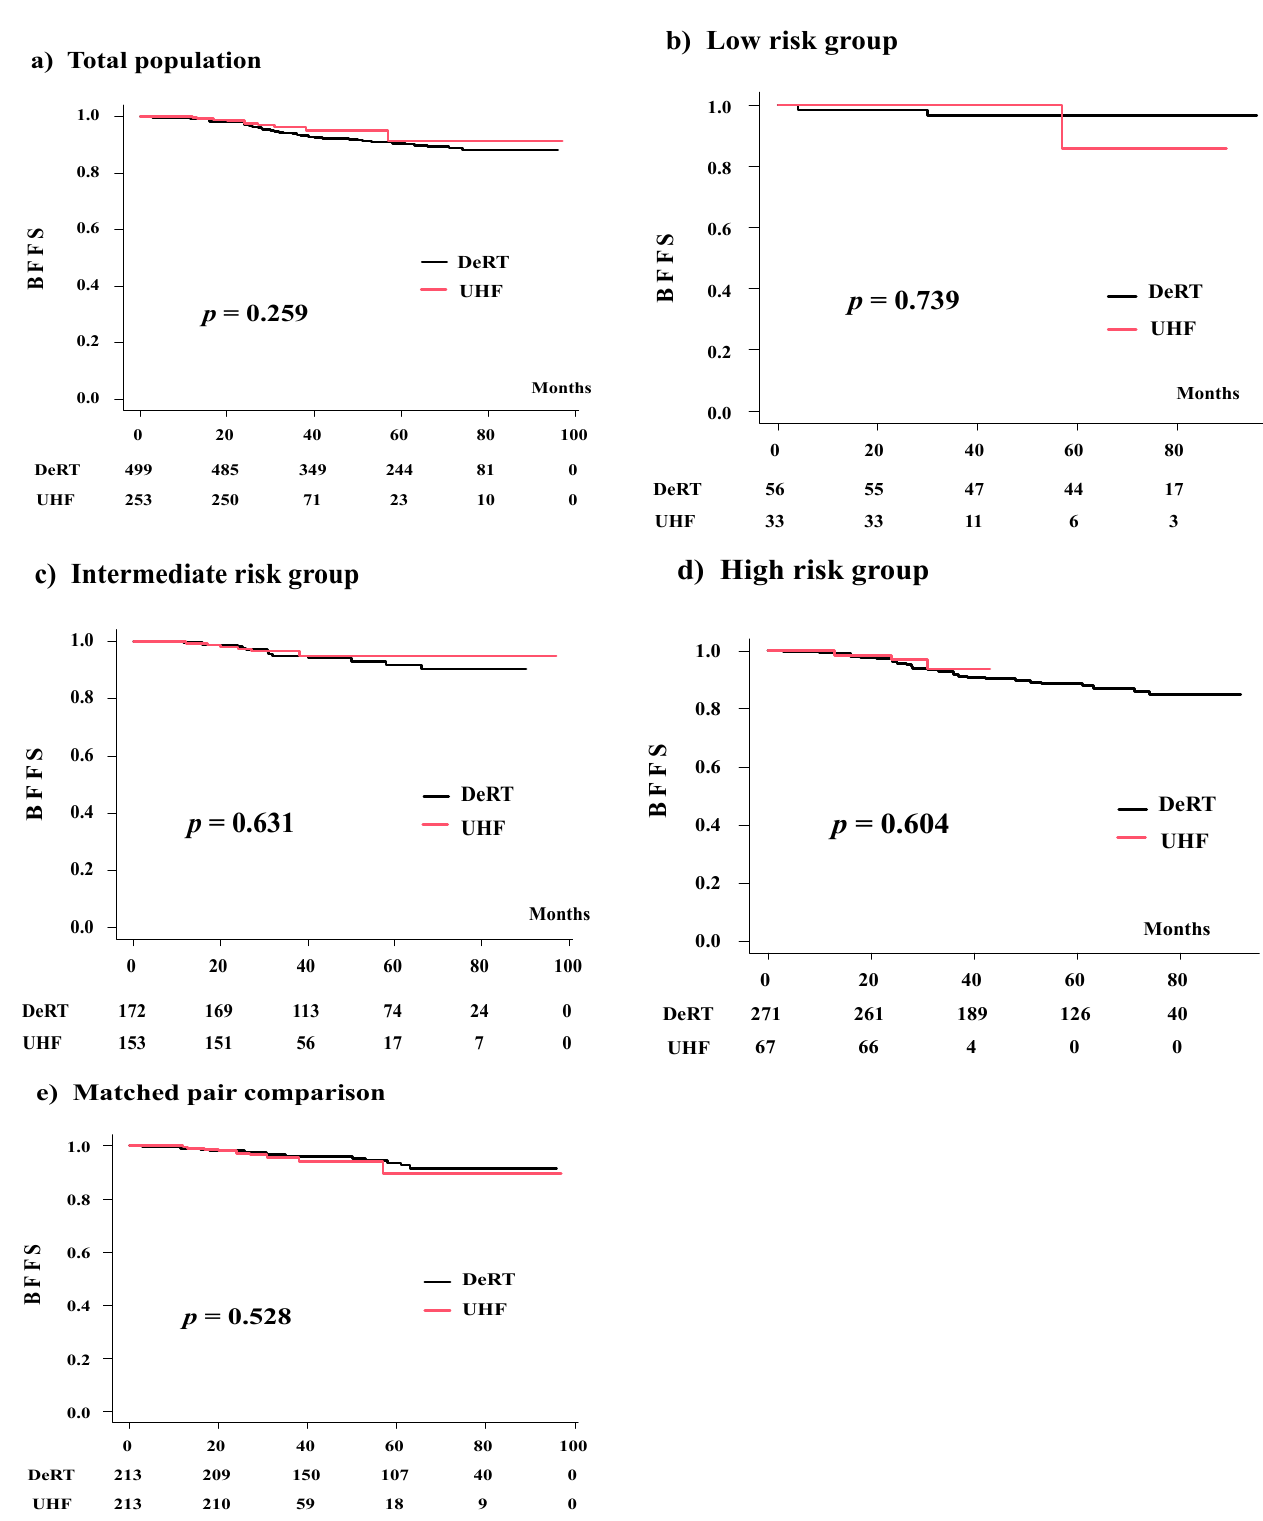
Figure 2. Biochemical control rates (BFFS) between UHF and DeRT. We generated a well-matched set of 213 patient pairs in each group. The actuarial 3-year BDFS rates were 95.6% (95% CI: 91.2–97.8%) and 95.9% (95% CI: 92–98%, p = 0.528, Figure 1d) in the UHF and DeRT groups, respectively. The hazard ratio was 1.321 (95% CI: 0.5547–3.147, p = 0.5293).